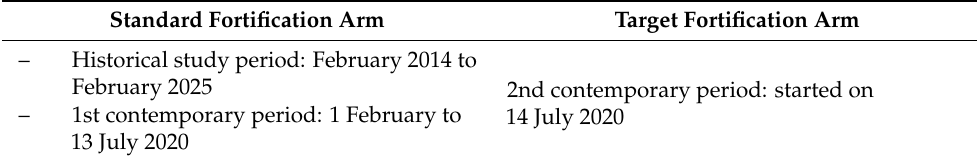
Table 1. Study periods for the standard fortification and the target fortification arms.